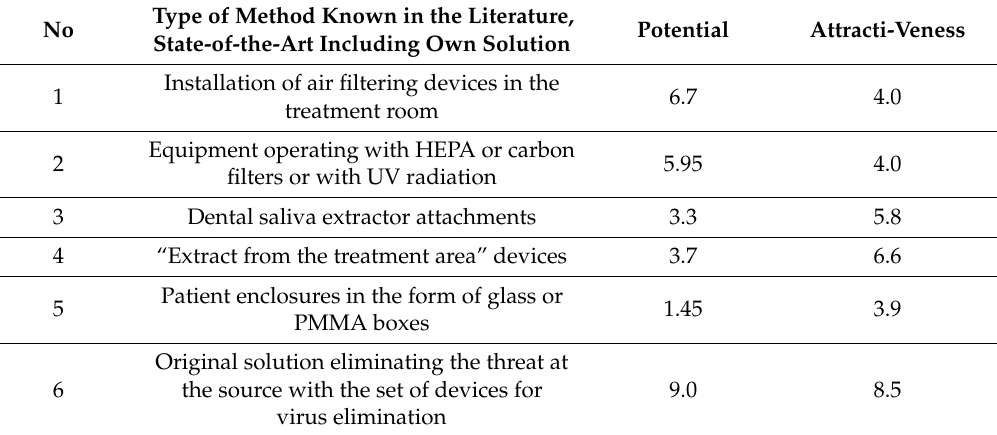
Table 8. The potential and attractiveness of each group of methods of protection against the e ff ects of the SARS-CoV-2